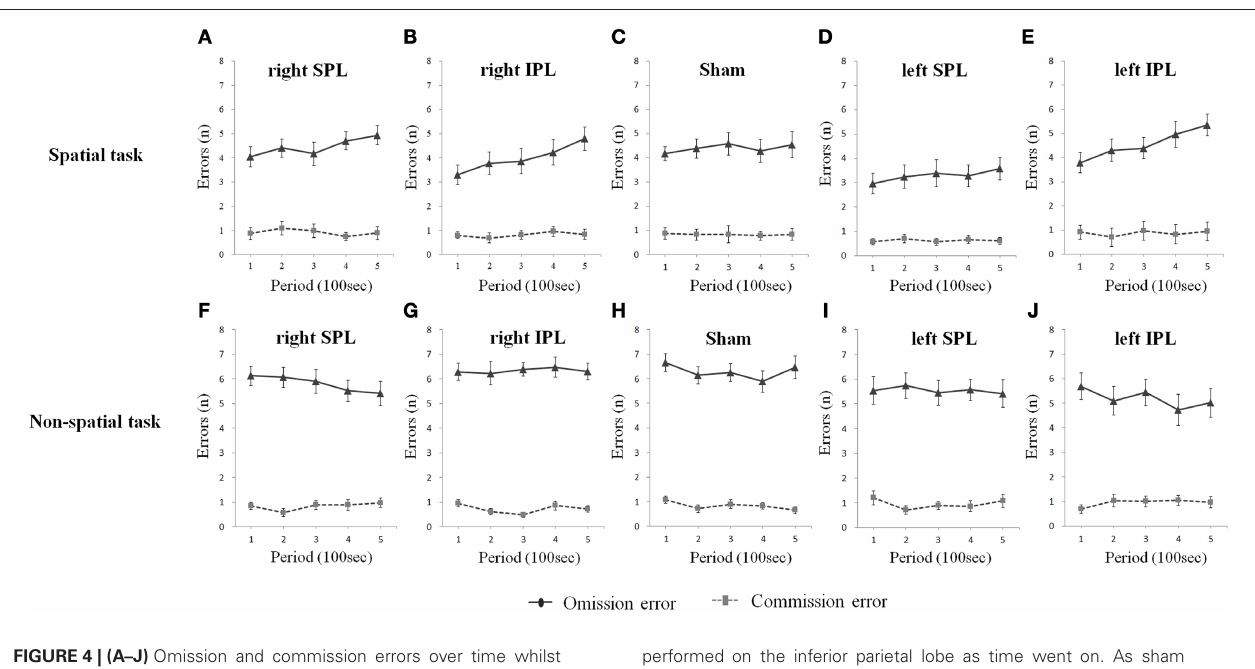
performed on the inferior parietal lobe as time went on. As sham condition, the same clicking sound with the real coil as real TMS was performed on the right parietal lobe. SPL and IPL stand for superior parietal lobe and inferior parietal lobe,